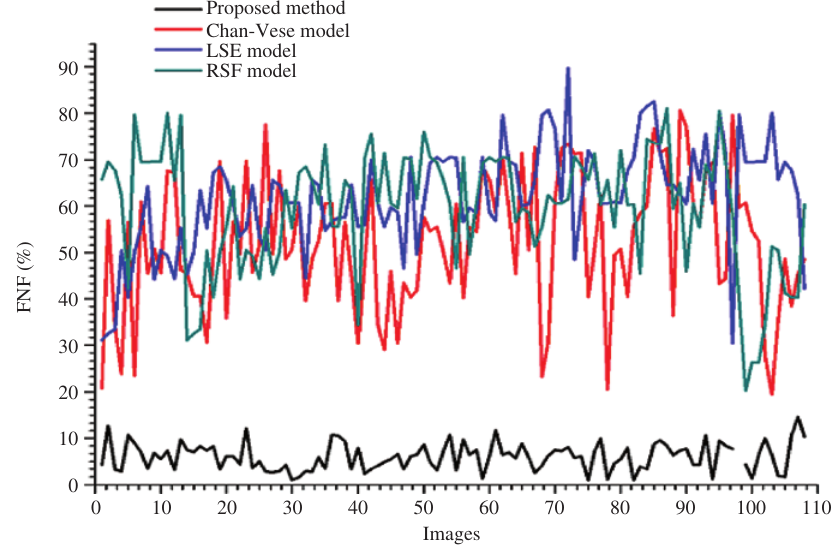
Figure 9: Comparison of Performance Evaluation Results using FNF.